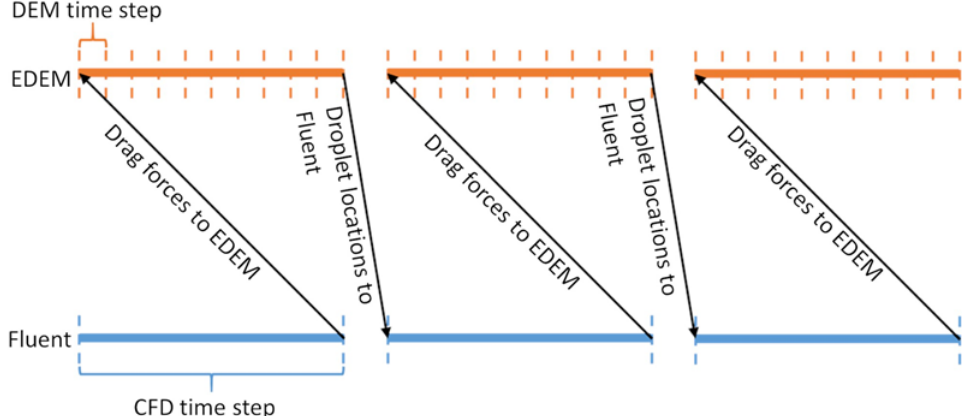
Figure 2. Illustration of the computational fluid dynamics–discrete element method (CFD–DEM) calculation process.